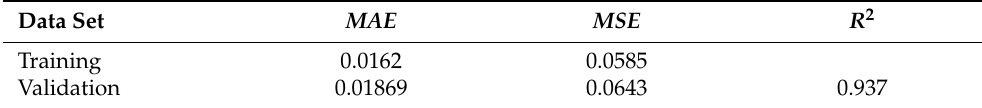
Table 3. Summary of ANN prediction results.